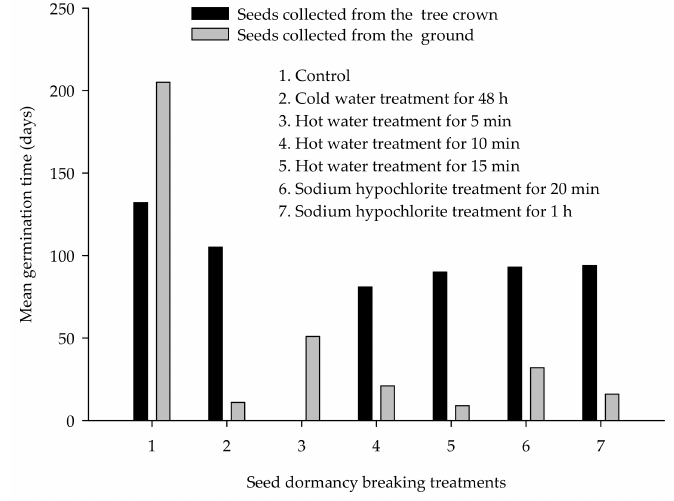
Figure 5. Mean germination time (days) of D. steudneri seeds collected from the tree and the ground with different presowing treatments in the greenhouse.